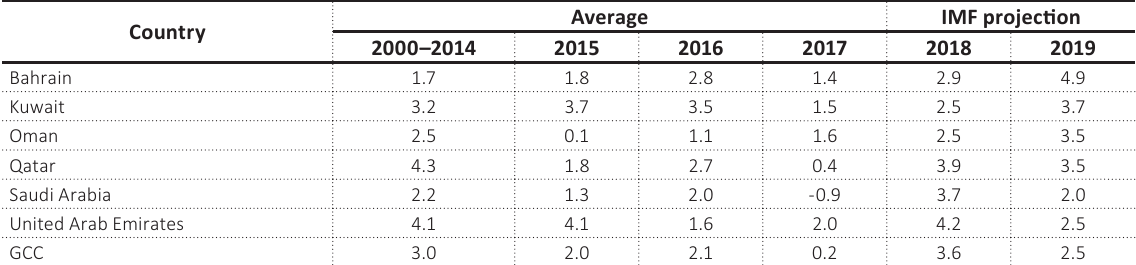
Source: International Monetary Fund dataset (average 2000–2014 to 2019).